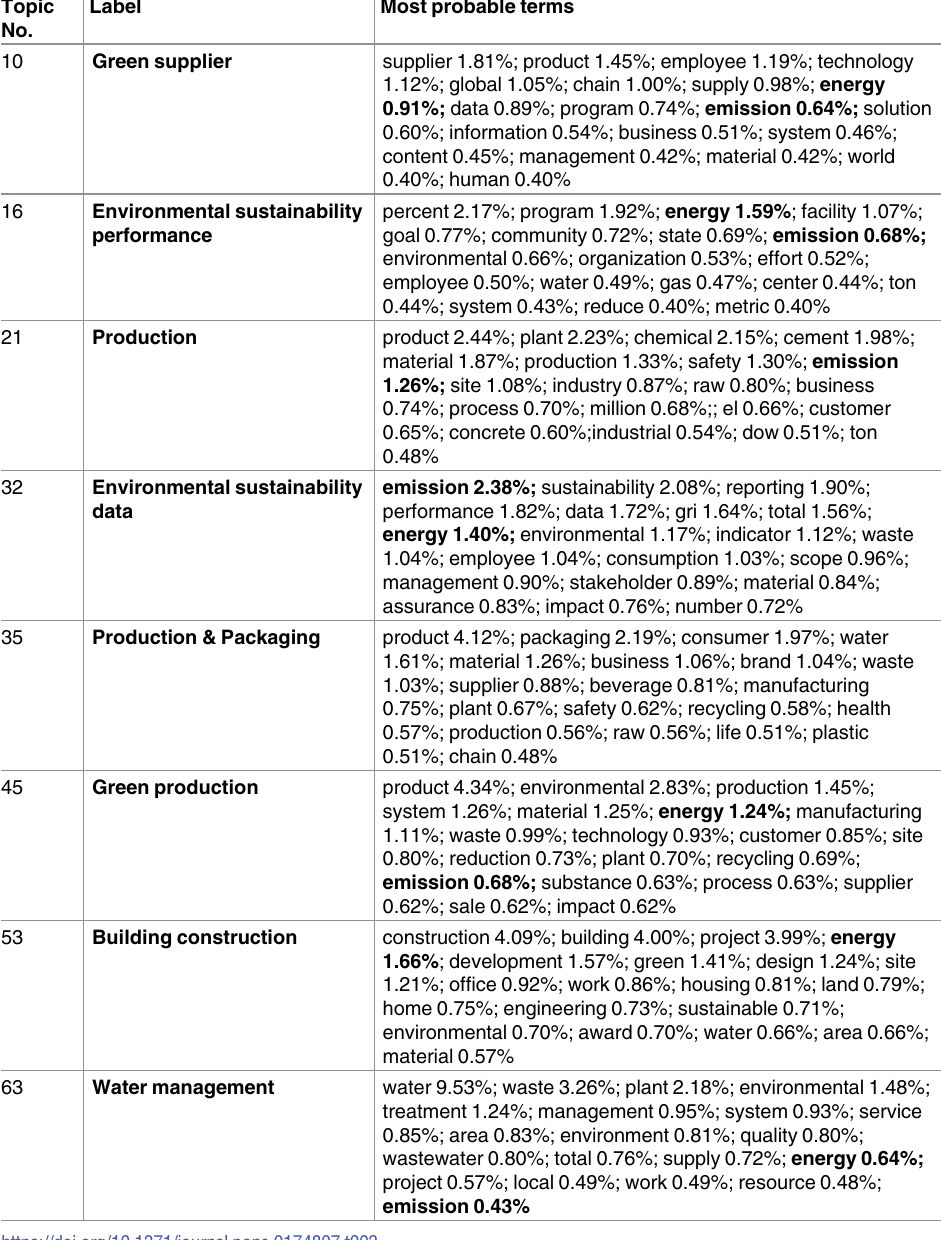
Table 3. Topics related to environmental sustainability. Topic